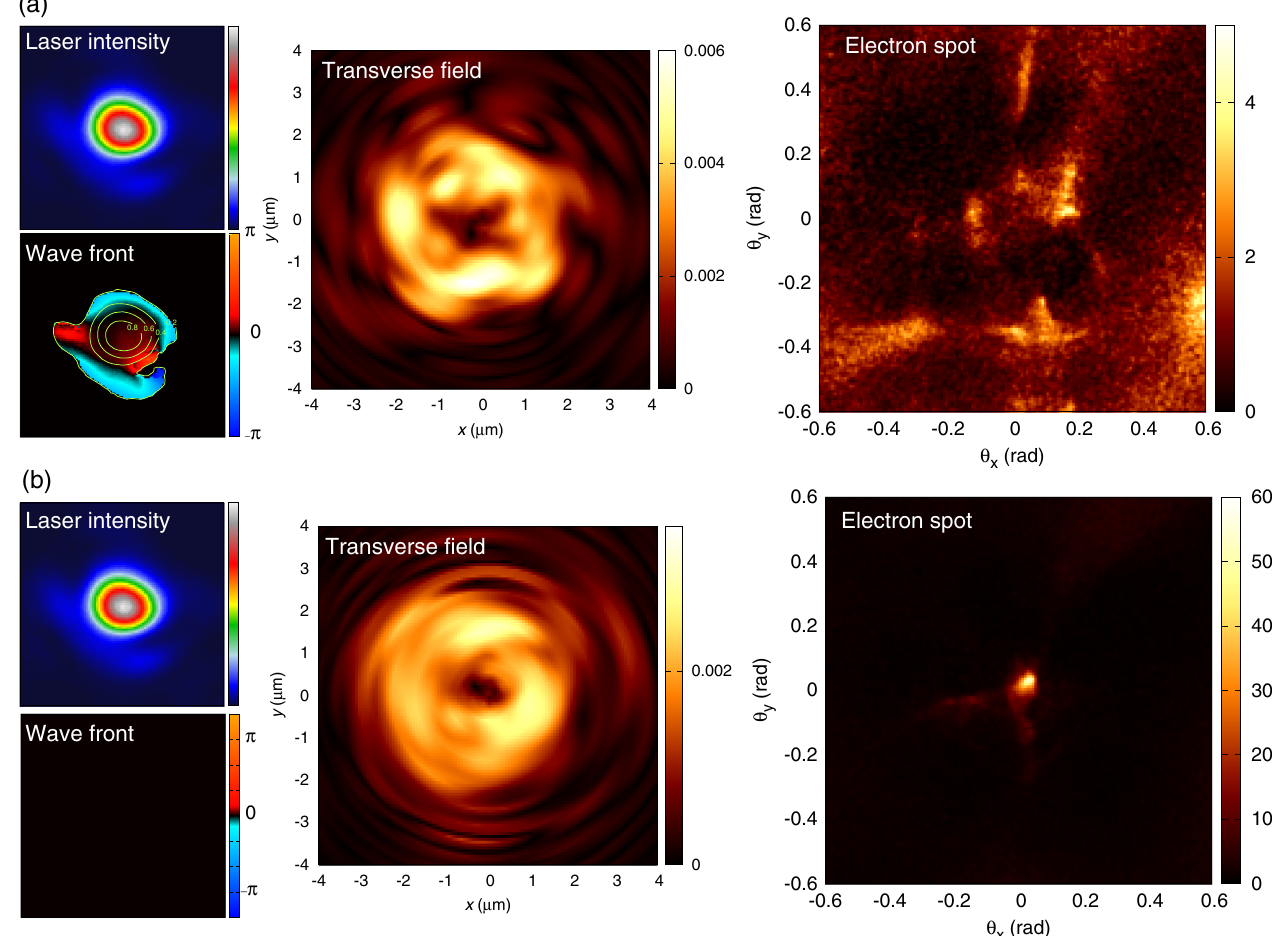
FIG. 5. Simulations results for a laser pulse with both focal spot and wave front reconstructed from experimental data (a) and with the same experimental focal spot but with a flat wave front (b) Left column: input intensity distribution and wave front at the focal plane. Central column: cross-sections of the transverse field E ⊥ =E 0 ( E 0 ¼ m e c ω p =e is the cold wave breaking field) at 0.6 ps and for z ¼ 28 μ m. Right column: electron spot far from the gas